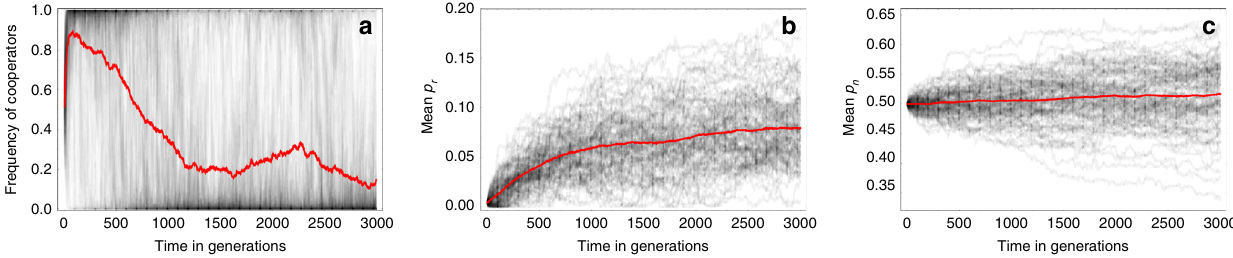
Fig. 3 Density of trajectories of frequency of cooperation ( a ), mean p r ( b ), and mean p n ( c ) from 200 replicate simulations, depicting coevolution of the linking probabilities with cooperation. In each panel, darker regions correspond to a higher proportion of replicate trajectories passing through that point. The red curve in each panel depicts the mean of 100 trajectories. Each trajectory starts with p r = 0.001 and p n = 0.5, which for these parameter values favors cooperation. Accordingly, cooperation is established quickly after starting at frequency 0.5, as indicated by the dark spot at the upper left corner of a , which indicates most trajectories initially converge to high frequency of cooperation. However, this is followed by an increase in the mean p r value of the population ( b ), and cooperation soon collapses, with trajectories increasingly spending time near zero frequency of cooperation. After cooperation has collapsed, p r continues its upward trajectory but under somewhat relaxed selection. In contrast to p r , there is no strong directional selection on p n , and trajectories spread out in both directions from the initial value in c . Parameter values are N = 100, B = 2, C = 0.5, D = 0, μ = 0.001, μ l = 0.01, δ = 0.1, σ n = 0.01, σ r =